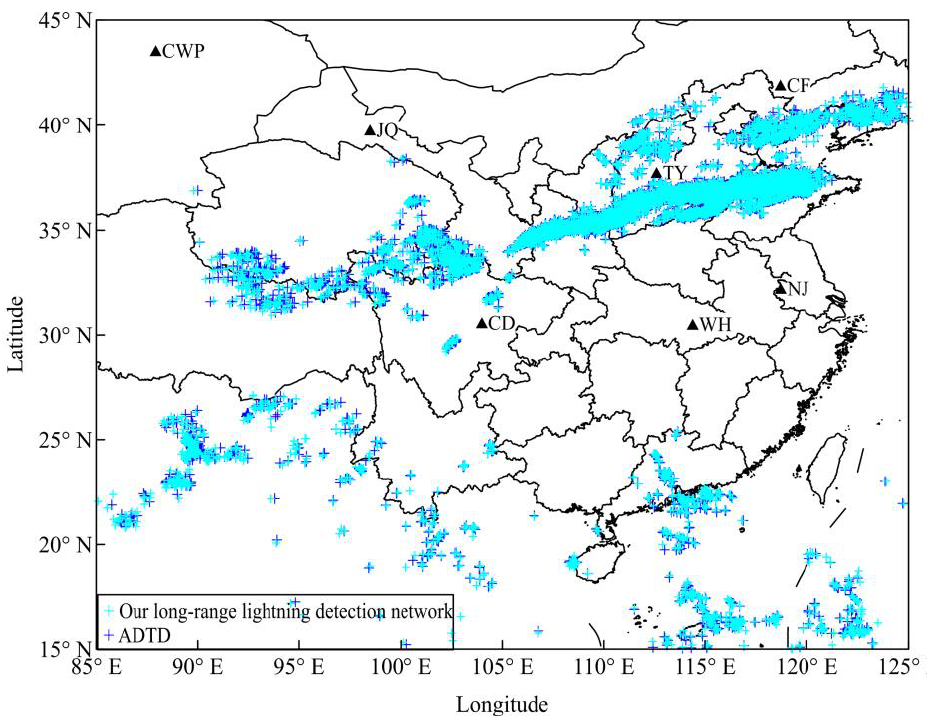
Figure 9 . The positions of the matched events on 3 October 2021.